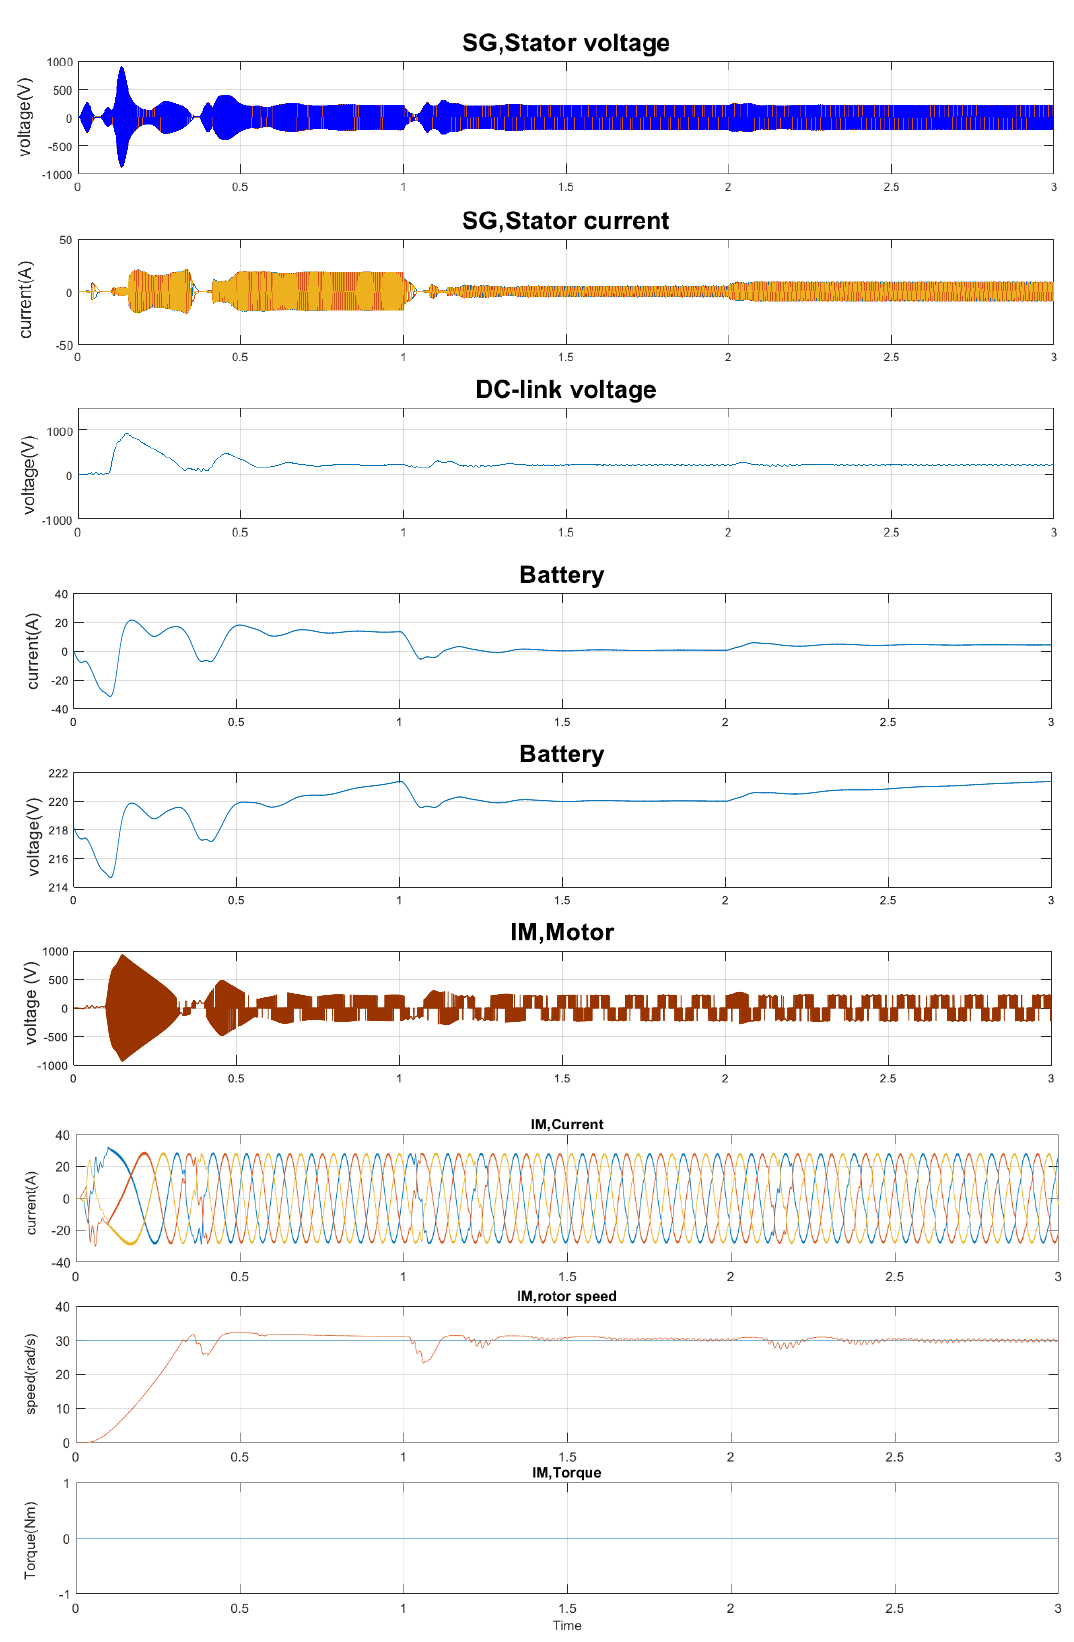
Figure 4. Effective reaction of autonomous wind/storage production component providing IM with the suggested control for step variations in velocity of the wind via both MBA and GA.